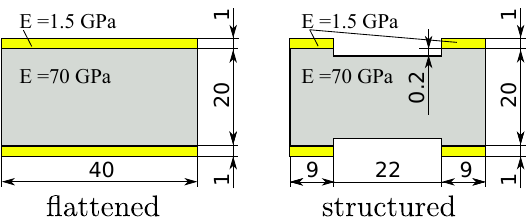
Figure 13. Schematics of the clamping geometries with the additional artificial elastic